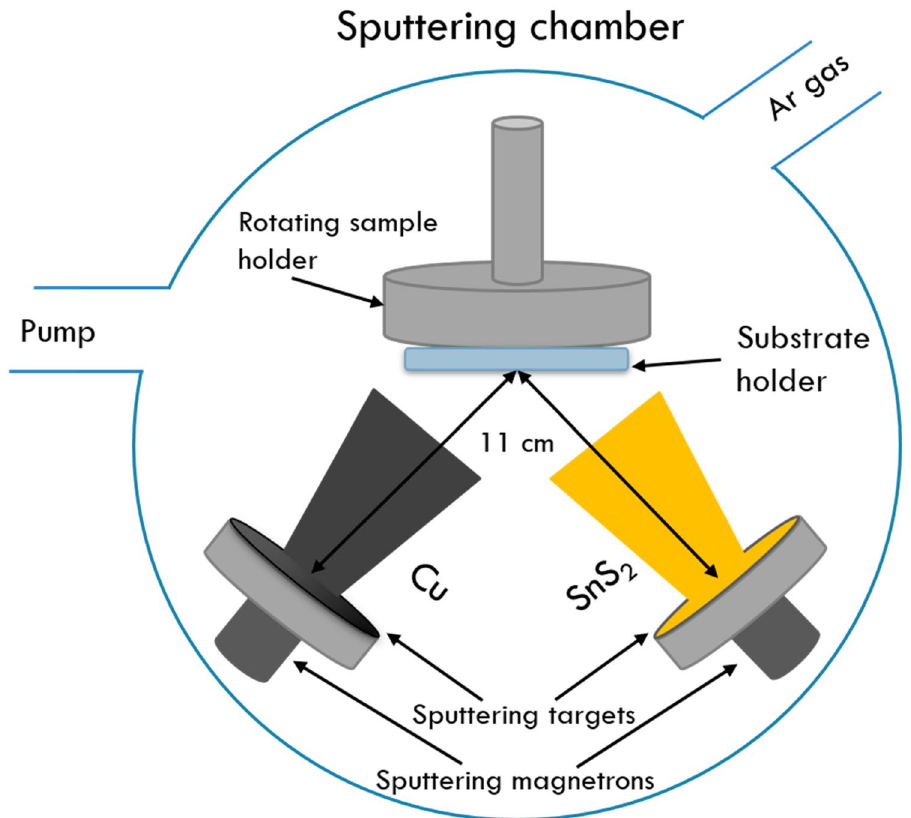
Figure 16. Schematic diagram of the deposition chamber.